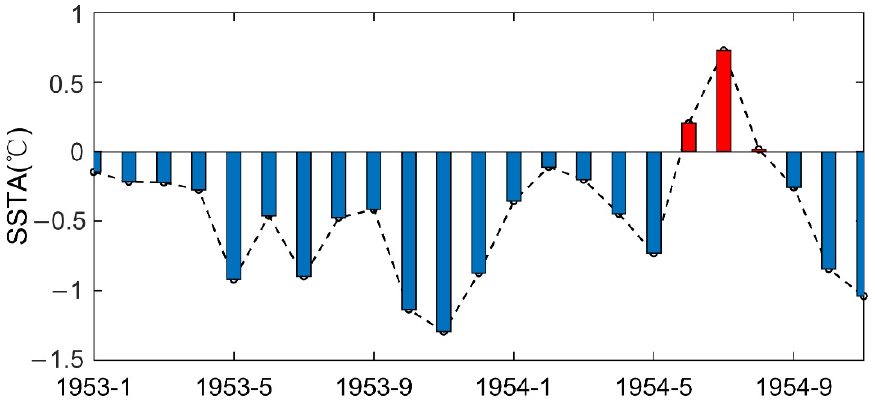
Figure 5. Sea surface temperature anomalies of the Sea of Okhotsk. The standardized anomalies of average monthly 500-hPa geopotential heights within the region of 120E–150E, 50N–60N were defined as the Okhotsk high index (OKHI). The index represents the activity level of a blocking high. An OKHI ≥ 1.0 indicates that the geopotential height anomaly exceeds the mean by 1 standard deviation, suggesting that the blocking high in question is active. Figure 6 presents the time series of OKHIs. In 1954,